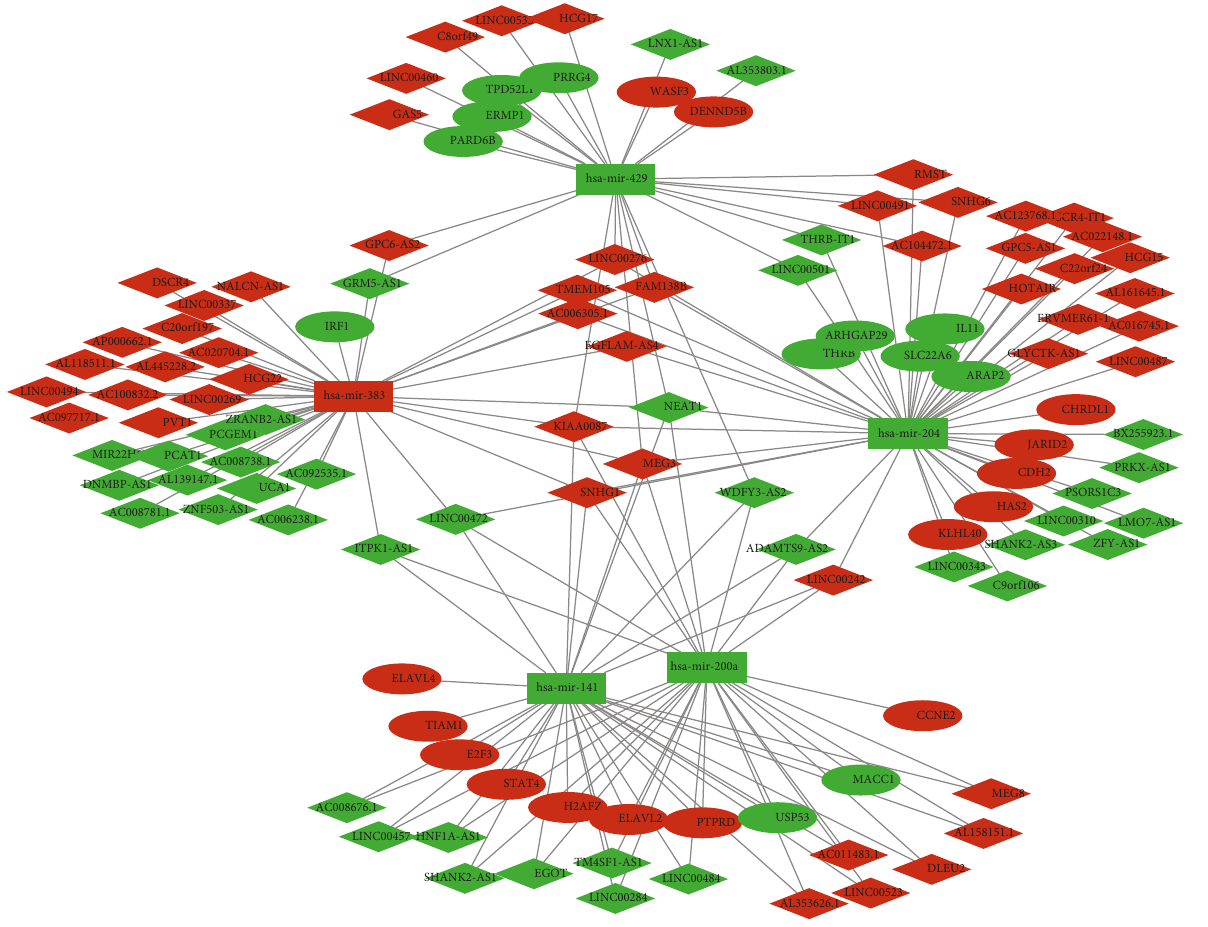
Figure 6: Construction of the ceRNA network.